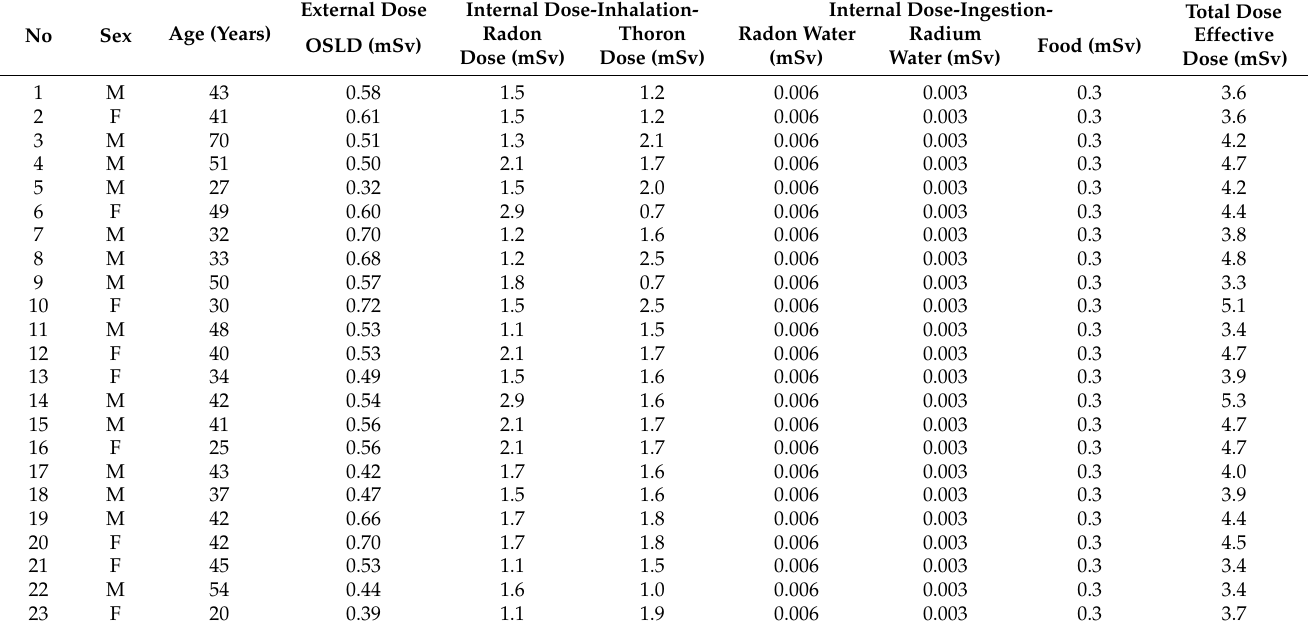
Table 1. Estimated annual effective dose of study subjects living in